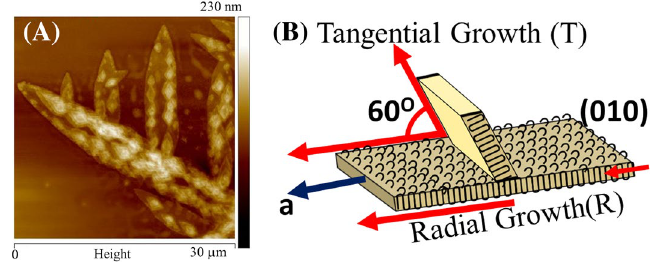
Figure 7. Representation of branching formation: ( A ) AFM images for lamellar branching at a specific angle (60° for PLLA) in branching, reprinted with permission from 22 , and ( B ) scheme for intersection angle in cross- hatch lamellae. Schemes re-drawn from Ref. 23